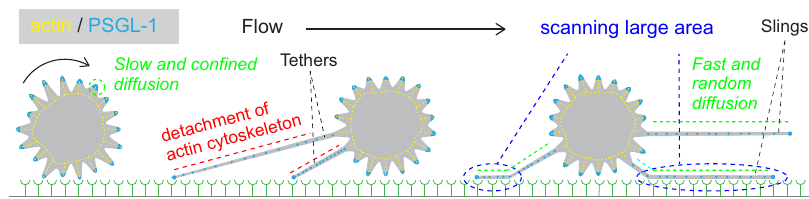
Fig. 9 Mechanistic model of leukemic cell rolling. Schematic illustration describing how the faster and random diffusional motion of the selectin ligands on the tethers and slings, due to the detachment of the cell membrane from the cortical actin cytoskeleton during the tether formation, promote stable and slow rolling the cell